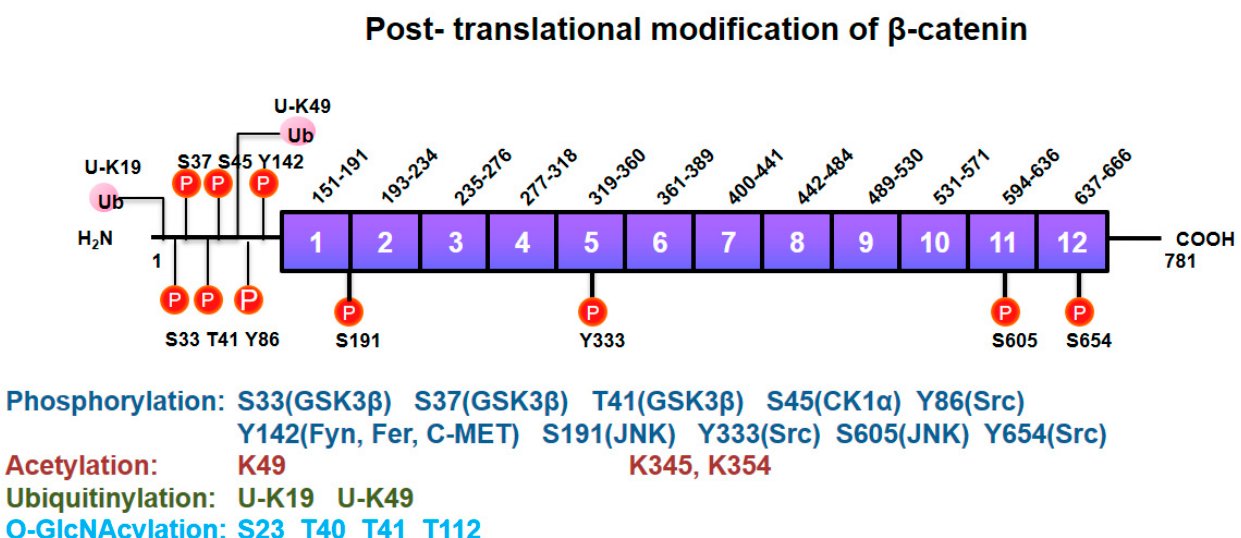
Figure 4. Post-translational modifications of β -catenin. β -catenin undergoes post-translational modifications including Ser/Thr and Tyr phosphorylation, acetylation, ubiquitylation, and O-GlcNAcylation for its own functional regulation. Kinases phosphorylating a specific site in β -catenin are denoted in parentheses.